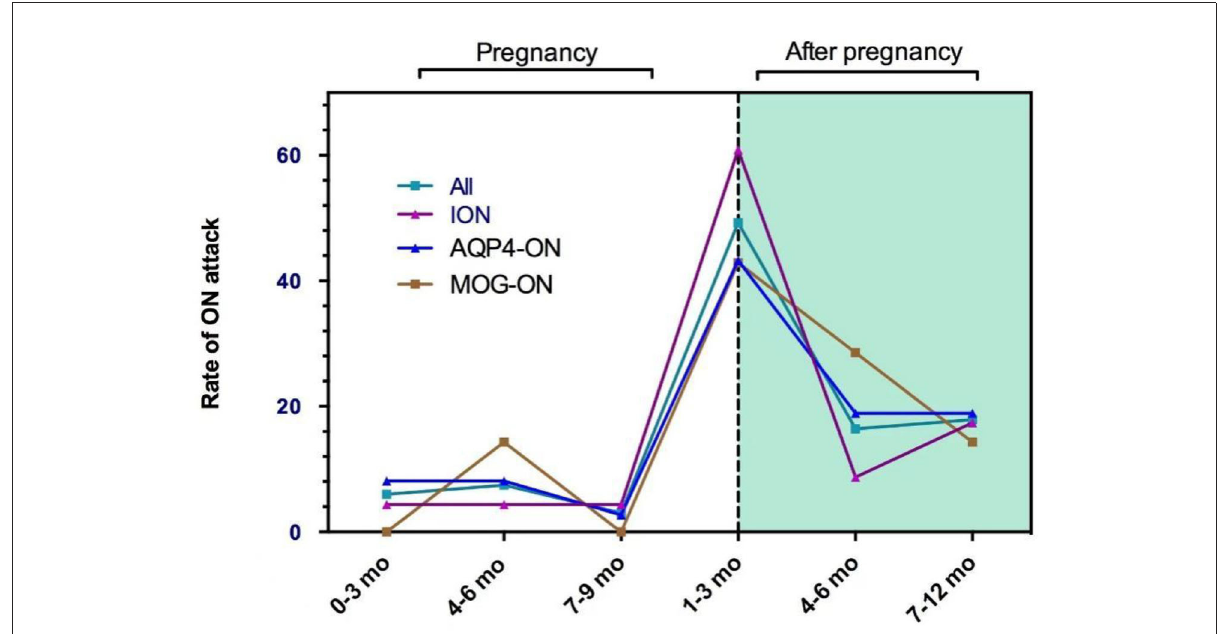
FIGURE1 The pregnancy-related ON attacks in the ION, AQP4-ON, and MOG-ON groups.